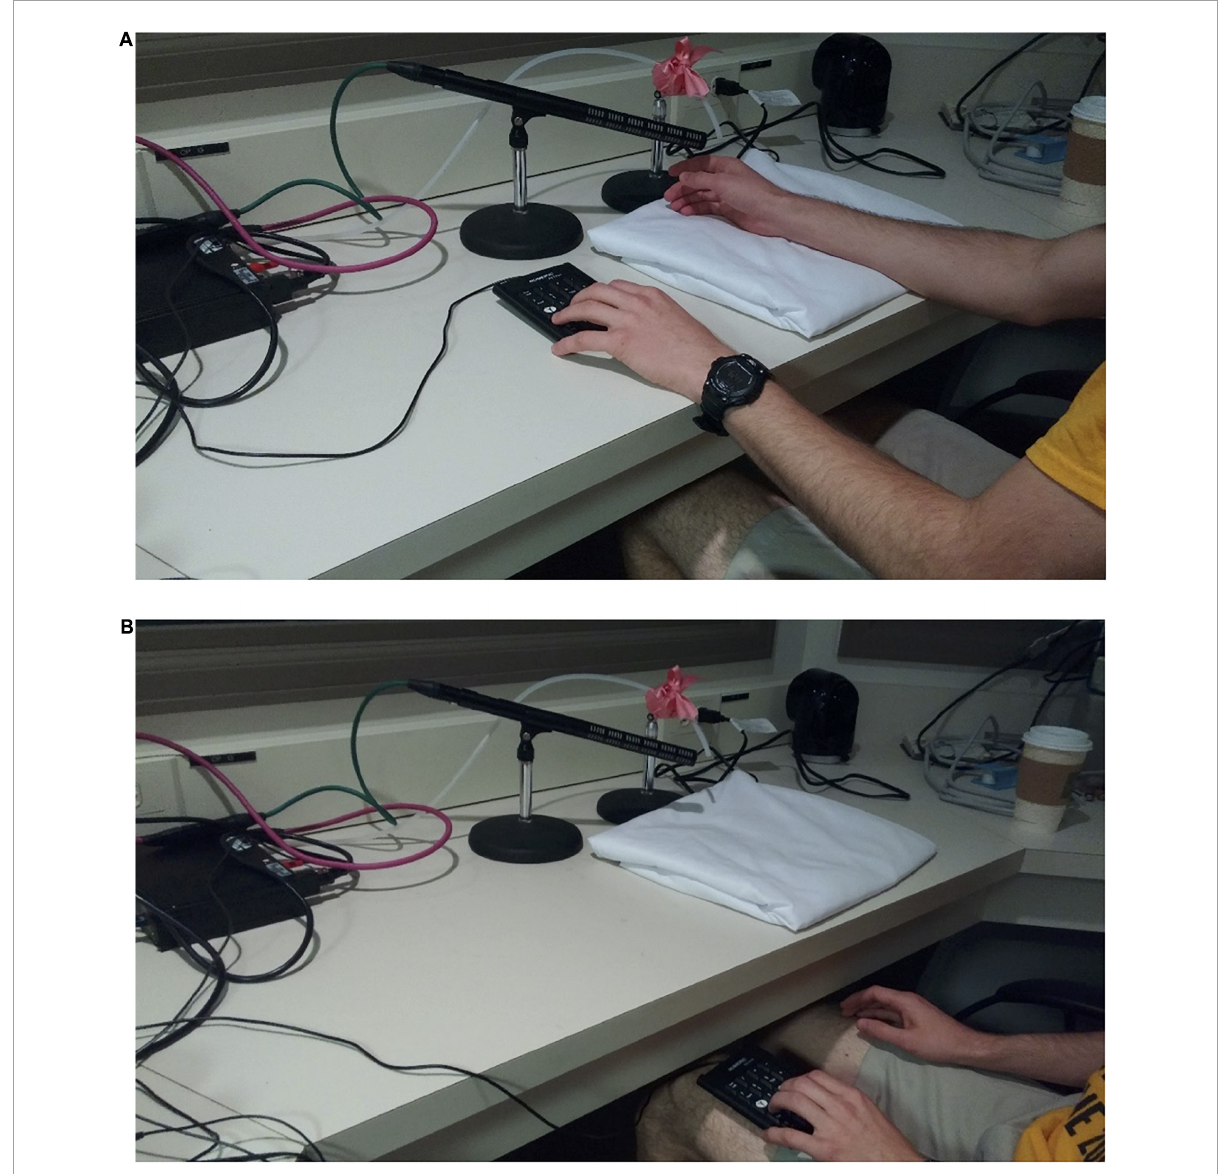
FIGURE3 (A) Puff delivery setup: participant right hand placed near outflow of airtube, left hand on response button box. Microphone records air puff delivery for verification of timing. (B) Puff detection test setup: participant right hand positioned away from outflow of airtube. This test determines whether participant can detect airflow from cues other than tactile hand